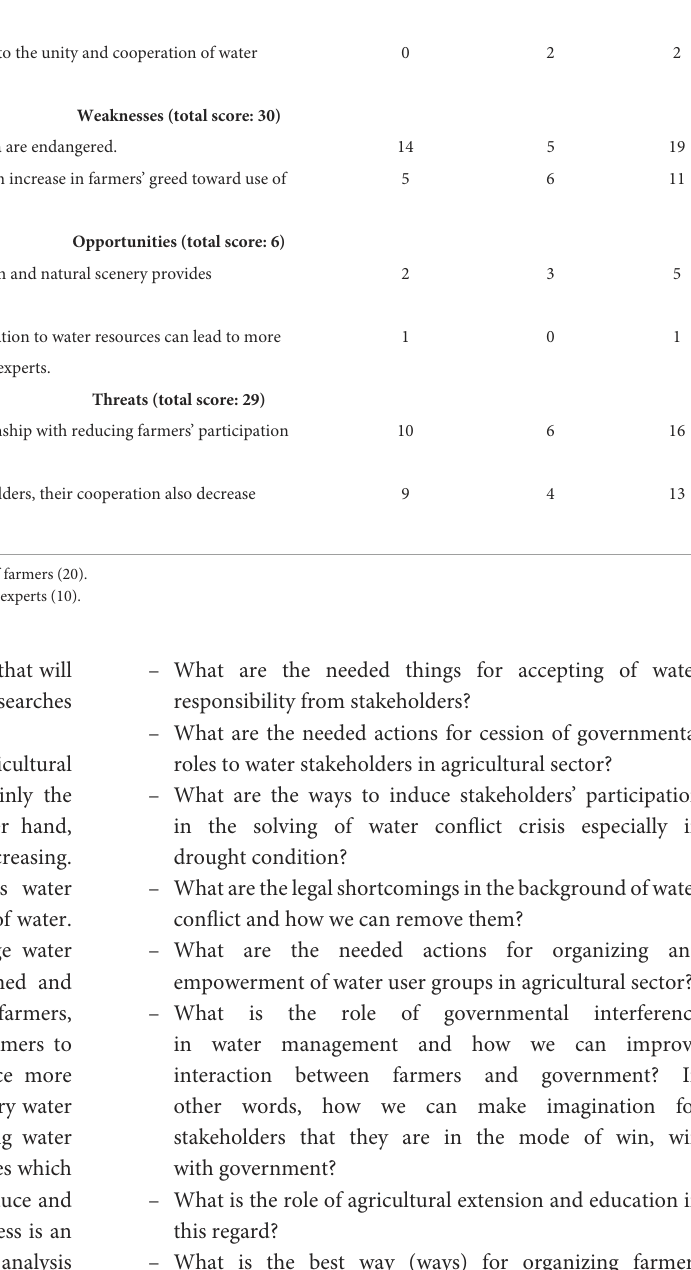
TABLE 9 SWOT matrix of environmental scarcity and degradation with water conflict: opinions of farmers and experts. Component Strengths and weaknesses Number of cases Farmers a Experts b Total Strengths (total score: